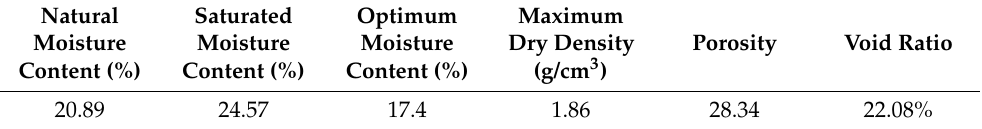
Table 1. Basic physical properties.